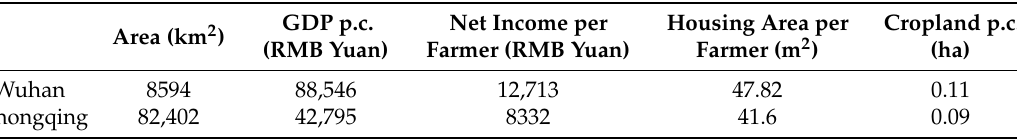
Table 1. General features of the two surveyed cities.